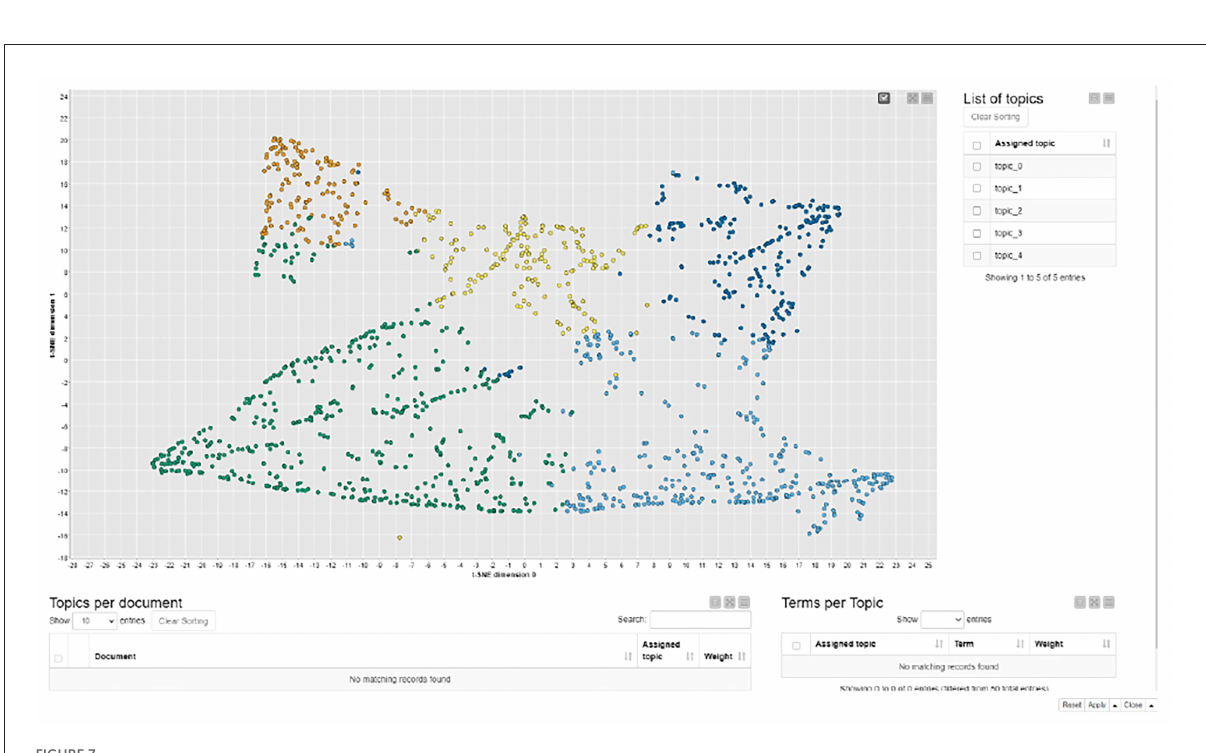
FIGURE7 Inspect topics and